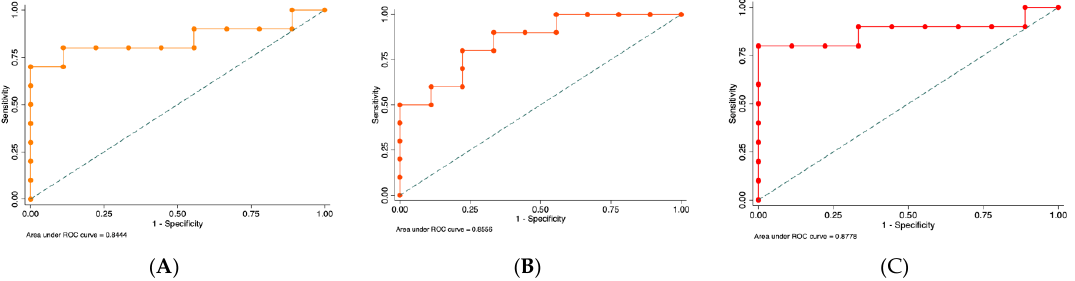
Figure 2. AUC-ROC curve analysis of selected miRNAs: ( A ) miRNA-20a (AUC-ROC: 0.84), ( B ) miRNA-30e (AUC-ROC: 0.85), and ( C ) miRNA-93 (AUC-ROC: 0.87). AUC-ROC: area under the ROC curve.